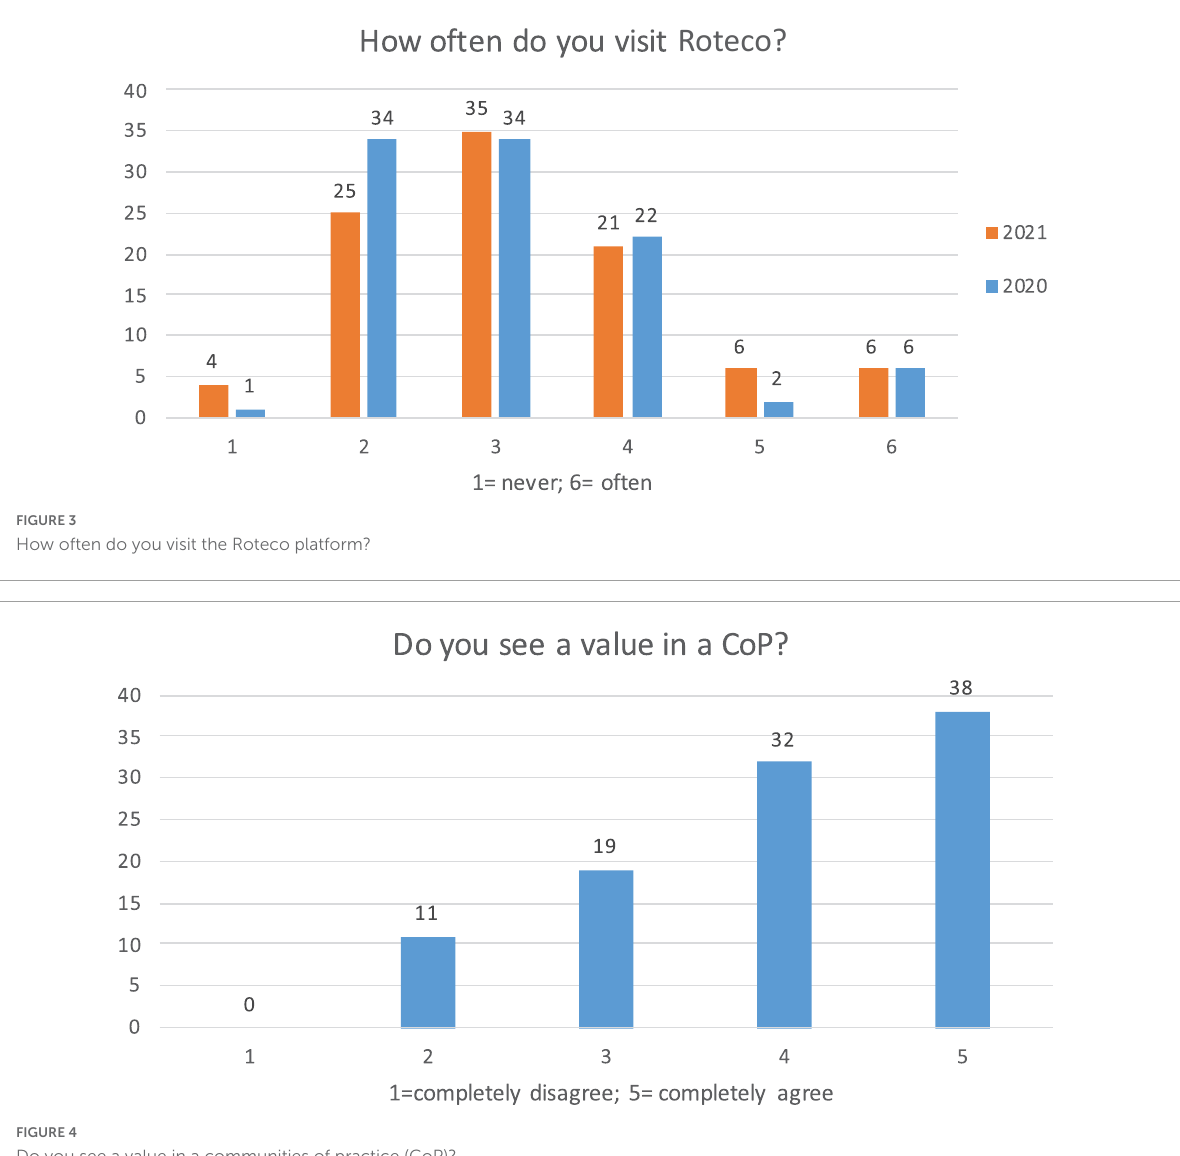
FIGURE4 Do you see a value in a communities of practice